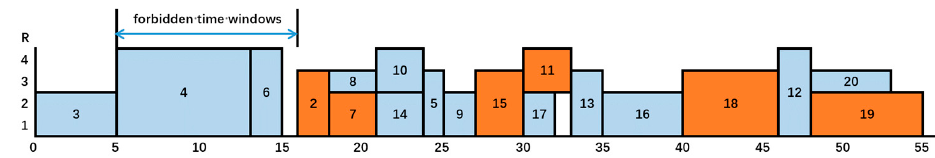
Figure 2. Schedule Figure 2. Schedule 1.